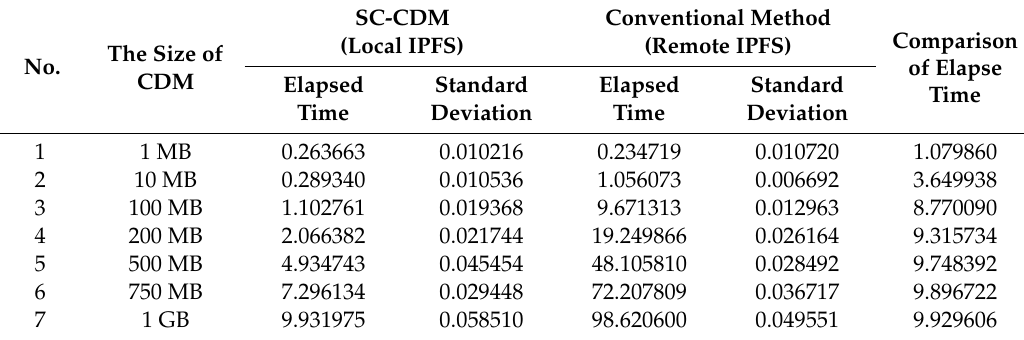
Table 4. Evaluation of storing CDM into a private IPFS network.